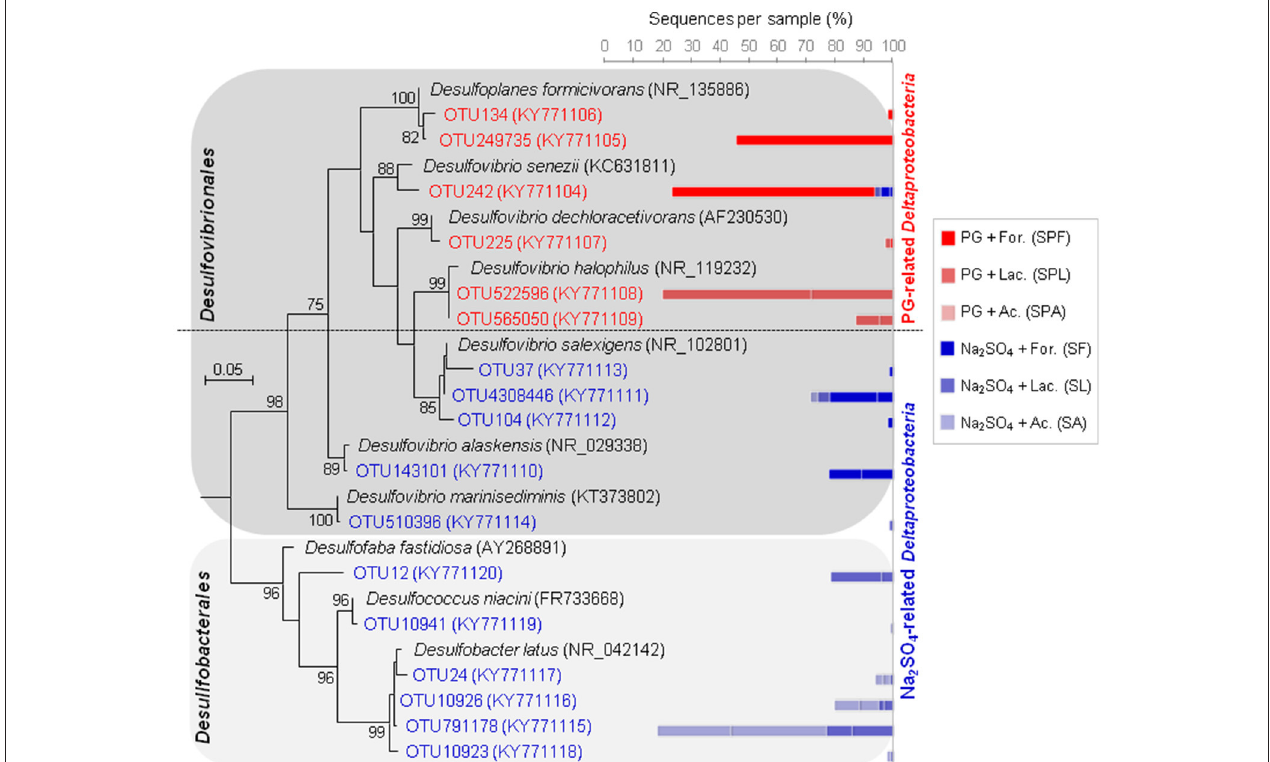
FIGURE 5 | Maximum-likehood (ML) tree based on 16S rRNA gene sequences showing the phylogenetic position of Deltaproteobacteria enriched from marine sediment (as inoculum) using different electron donors and sulfate sources (sodium sulfate or phosphogypsum). Representative sequences in the tree were obtained from GenBank (accession number in the brackets). Bootstrap values > 75% are indicated at nodes. The bars represent the relative abundance of each OTU affiliated with Deltaproteobacteria in the enrichment cultures. The blue bars indicate the relative abundance of OTUs in sodium sulfate cultures, whereas the red bars represent the relative abundance of OTUs in PG